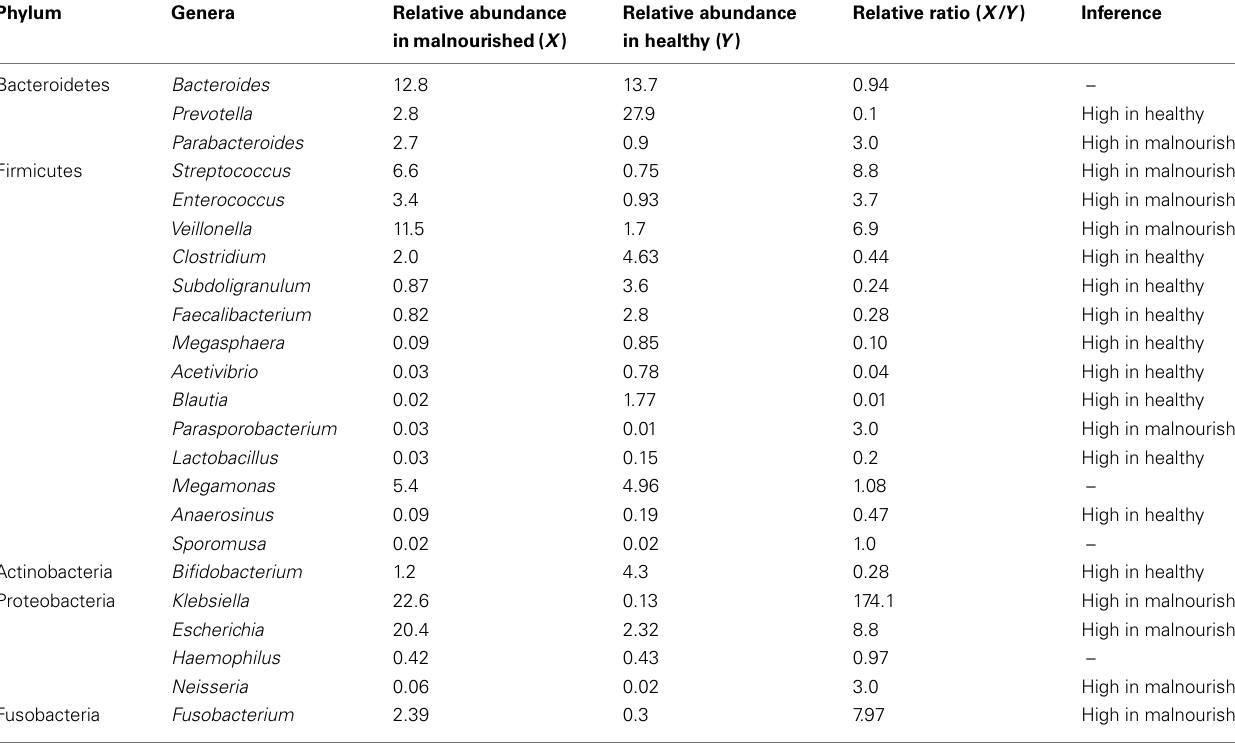
Table 2 | Comparison of genera assignments obtained for malnourished and healthy children at the taxonomic level of phylum.